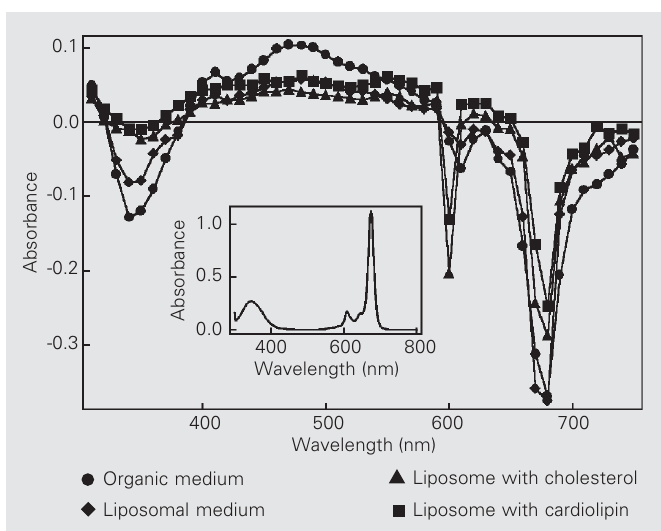
Figure 5. Transient absorption spectra of zinc phthalocyanine (ZnPC) in organic (pyridine) and liposomal medium, in the presence and absence of the additives - liposome with cholesterol, and liposome with cardiolipin - after excitation at 670 nm (50 mJ per pulse), showing the absorption of the triplet state centered at λ = 480 nm and the bleach of the ground state centered at around 350 and 680 nm. Inset , Absorption spectra of ZnPC in